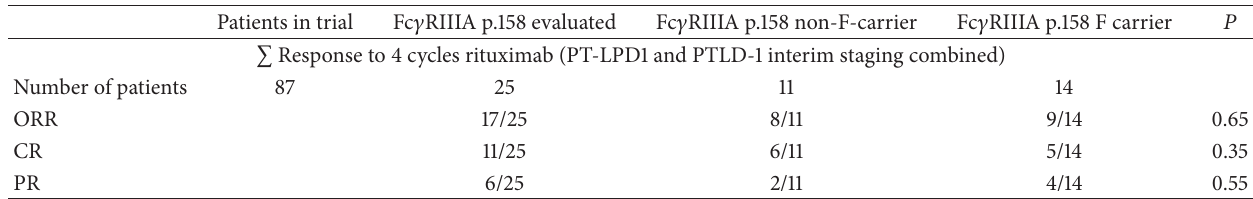
Table 4: Treatment response by Fc 𝛾 RIIIA polymorphism p.V158F: non-F-carrier versus F carrier. Patients in trial Fc 𝛾 RIIIA p.158